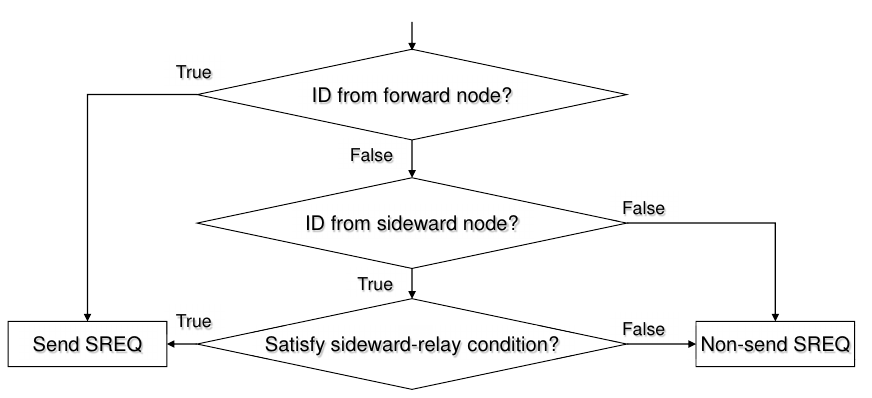
Figure 5. An example of a routing